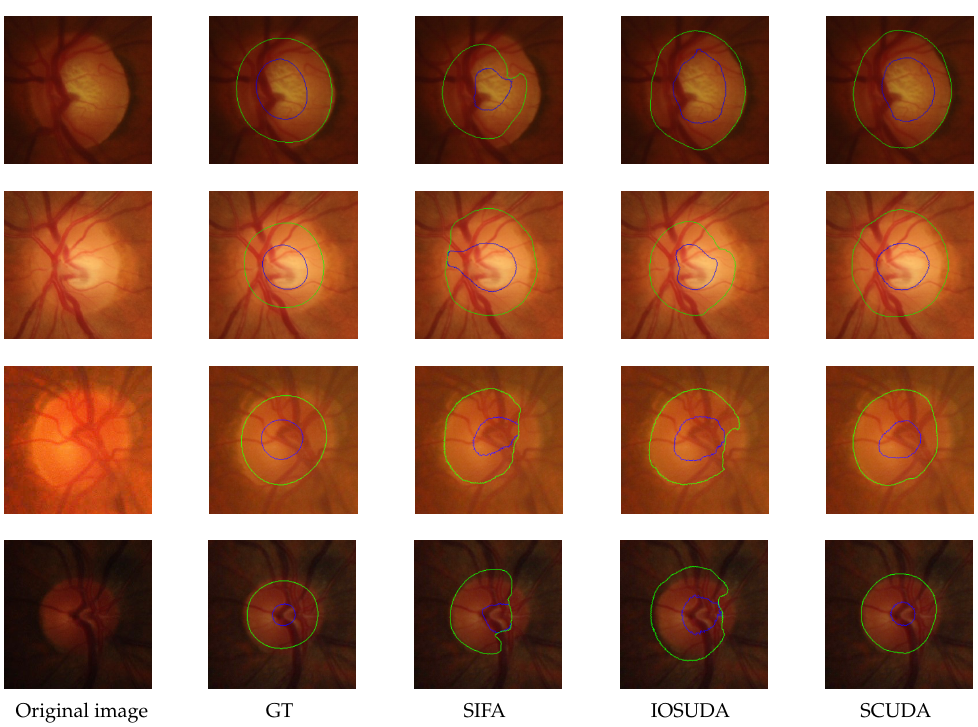
Figure 7. Representative visual examples of the RIM-ONE_r3 test set; the green contours indicate the boundary of the optical disc and the blue contours indicate the boundary of the optic cup. From left to right: original images, GT, and the results of SIFA, IOSUDA, and our proposed SCUDA.